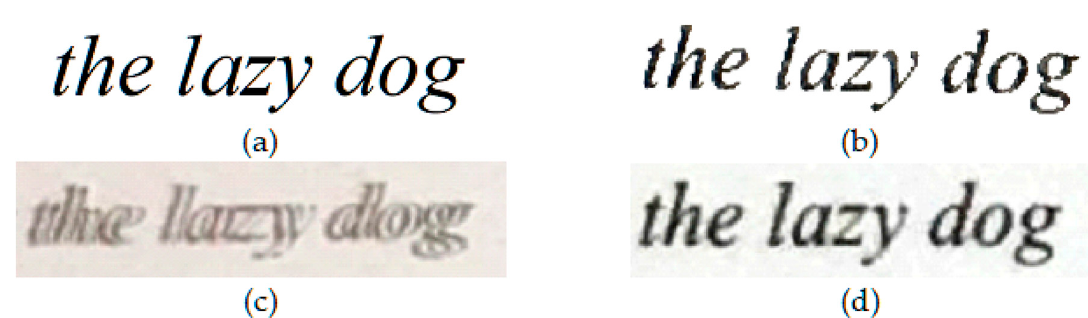
Figure 4. Zoomed results extracted from the smallest line of an image from the synthesized text image dataset, scanned using a smartphone with the image showing on a tablet screen. ( a ) Original Image; ( b ) CleanPage; ( c ) Google PhotoScan; ( d ) Microsoft Office Lens.